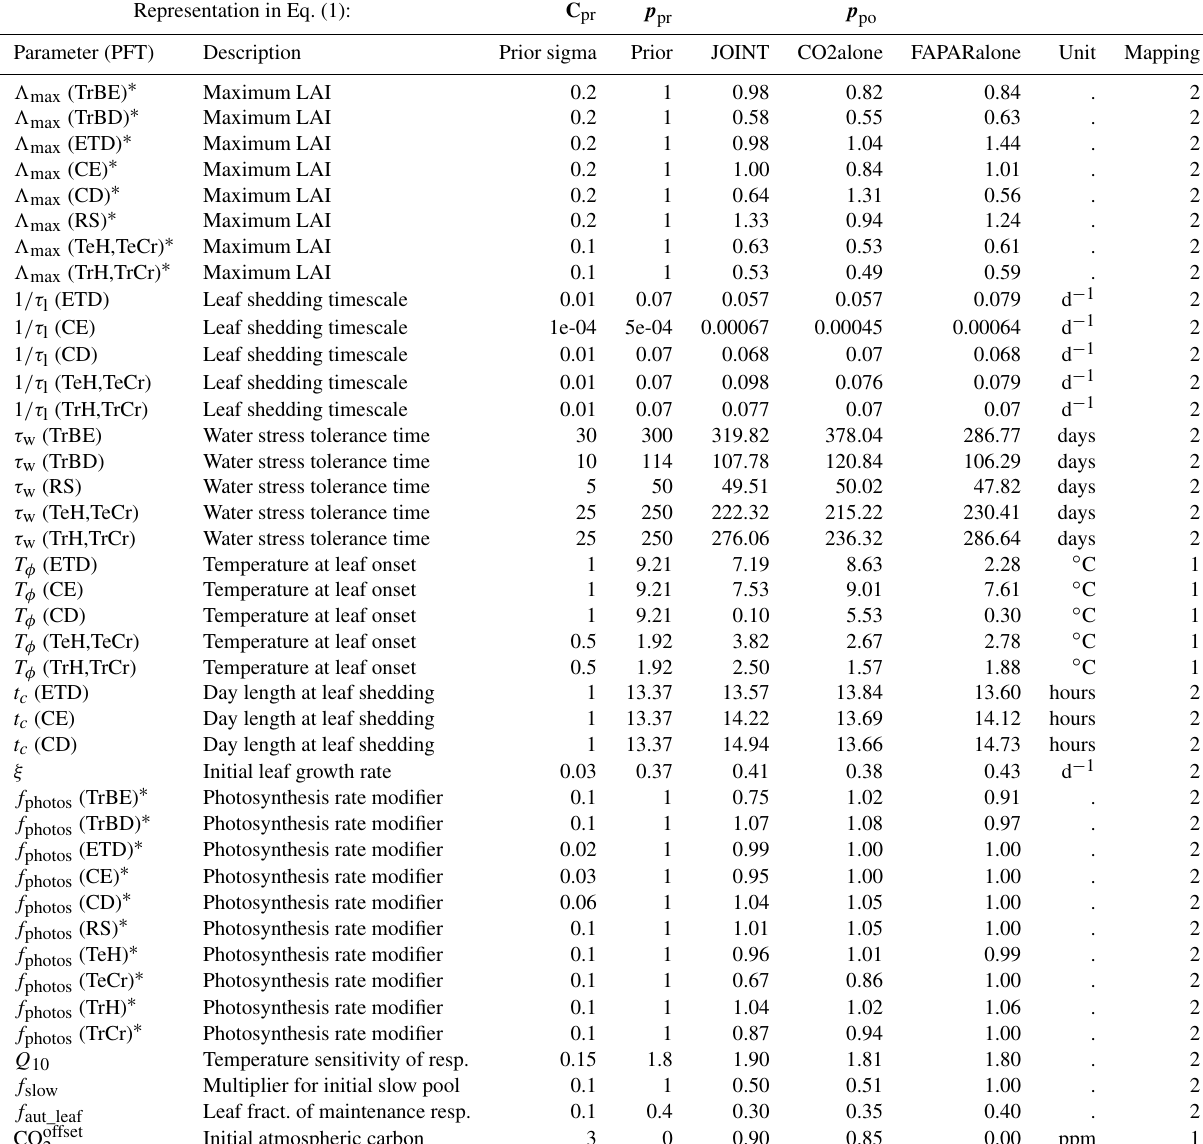
Table 2. Model parameters used in the data assimilation procedure with their prior and posterior values for the different assimilation ex- periments. Parameters marked with ∗ represent scalars that are multiplied with their respective value in the model, given in Table D1. The mapping variants are explained in Appendix C: (1) no lower bound; and (2) a lower bound at 0 for those parameters that are not allowed to take negative